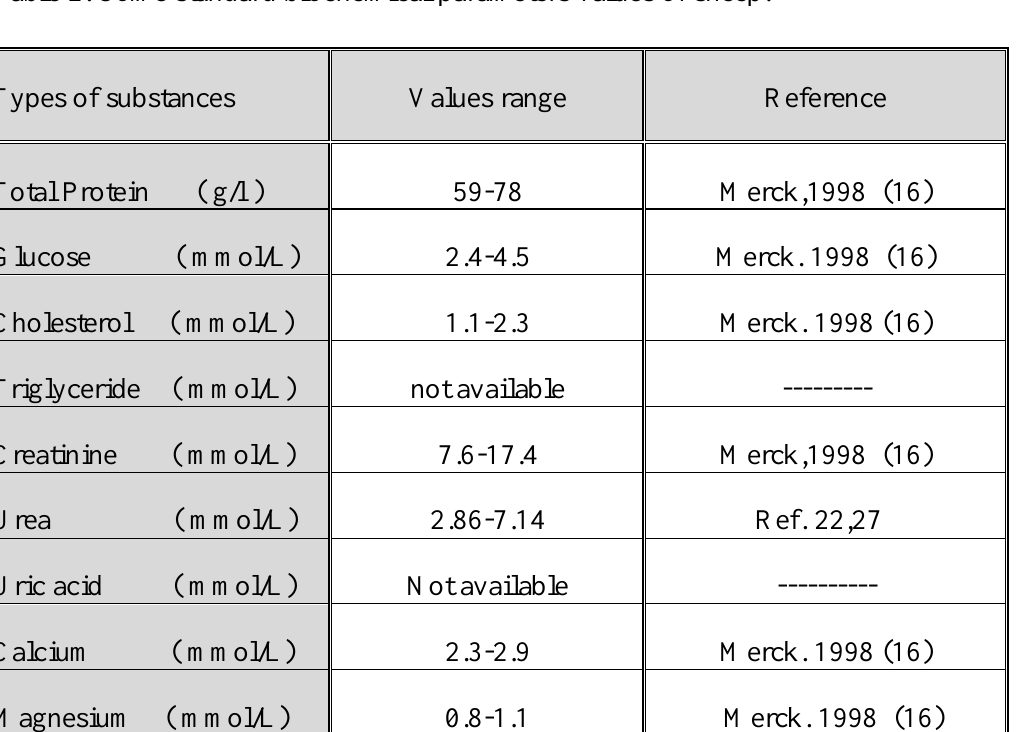
Table 2: Some standard biochemical parameters values of